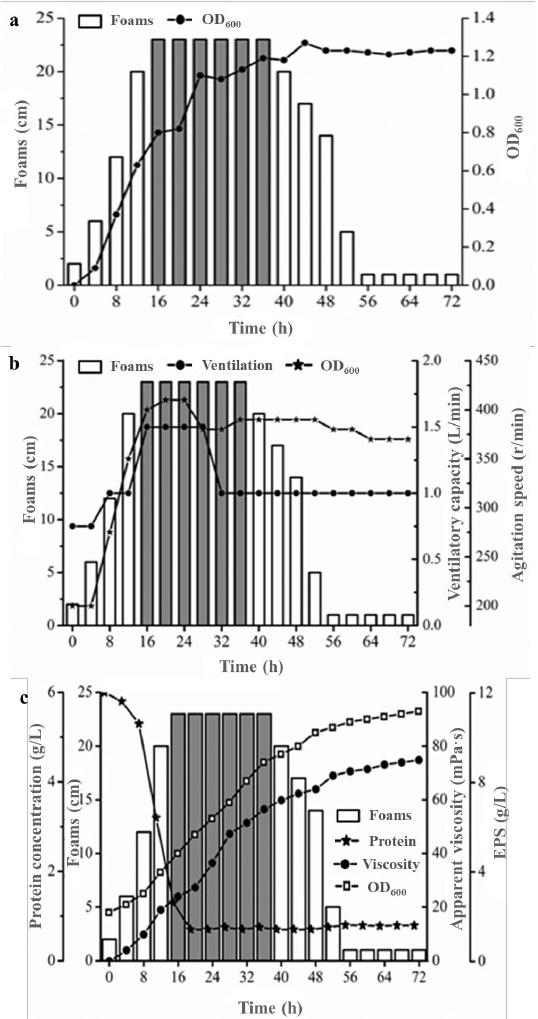
Figure 2. Causes of severe foaming in fed-batch fermentation by S. pararoseus JD-2. ( a ) The relationship between defoamer and frothing. ( b ) The relationship between ventilation and frothing. ( c ) The relationship between the properties of broth and frothing. The dark histograms represent the high of foams excess of fermenters. The data represent mean values and standard deviations obtained from three independent cultivations.